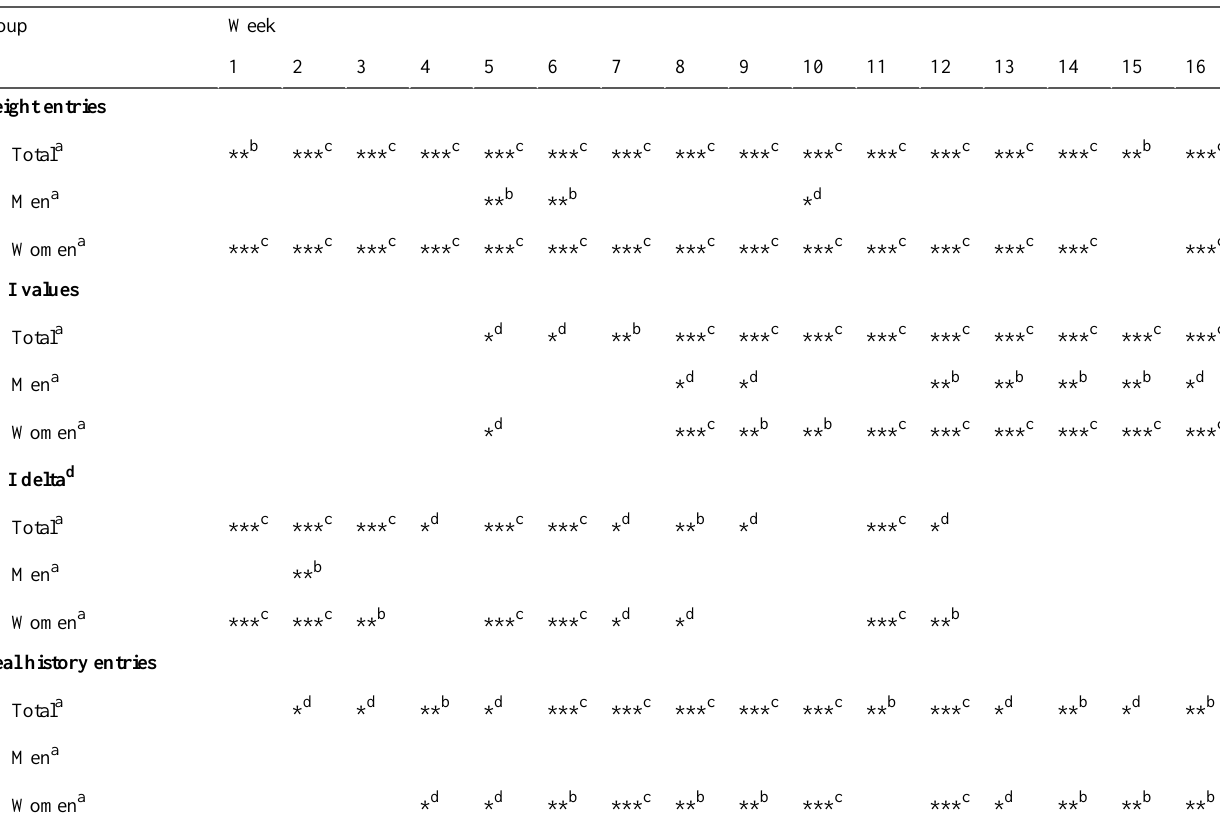
Table 2. Significance of analysis of variance (ANOVA) test results comparing the differences between groups for 16 weeks. P values were adjusted by the false discovery rate using the Benjamini-Hochberg method, and the actual P values are available in Multimedia Appendix